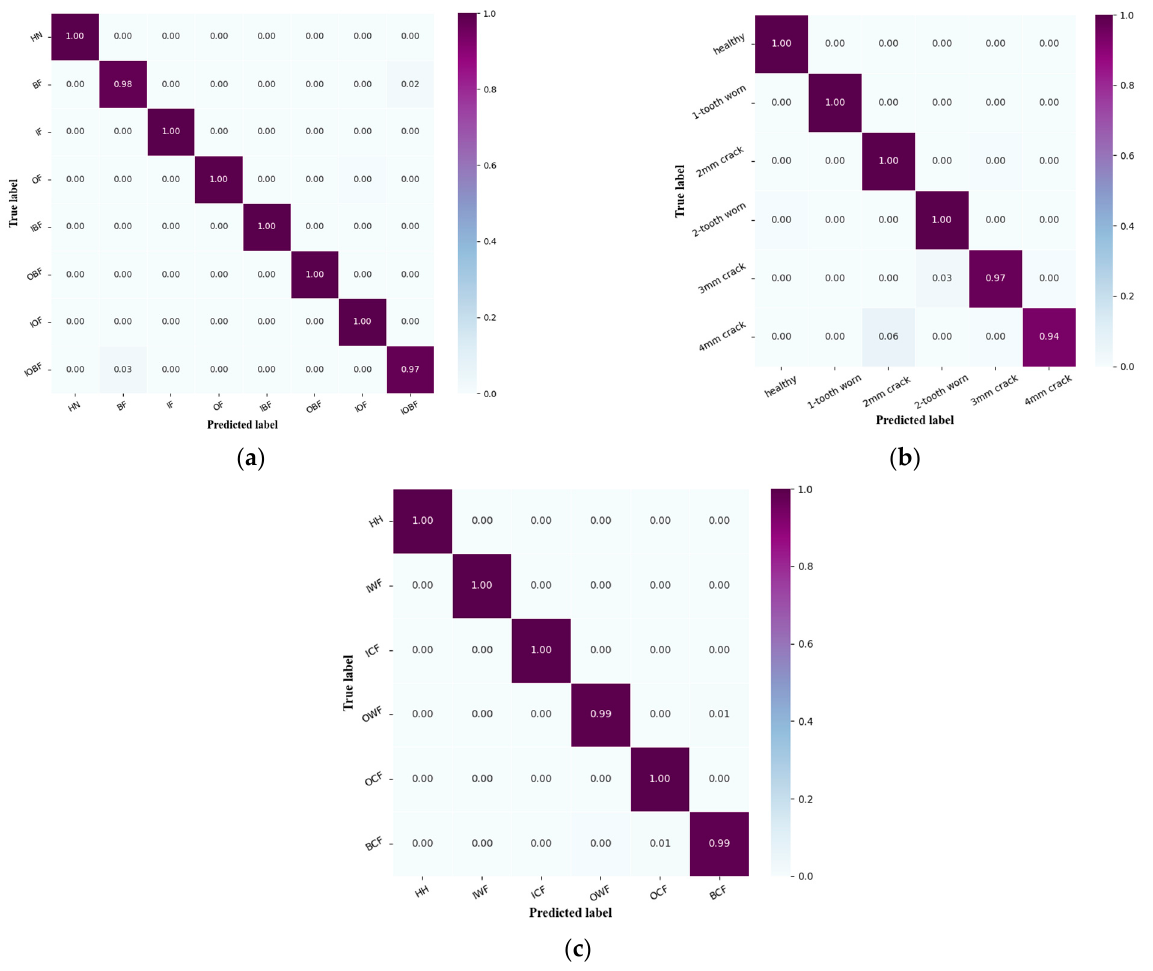
Figure 12. AMC-RSN with visualization of confusion matrix. ( a ) Case I. ( b ) Case. II. ( c ) Case III.